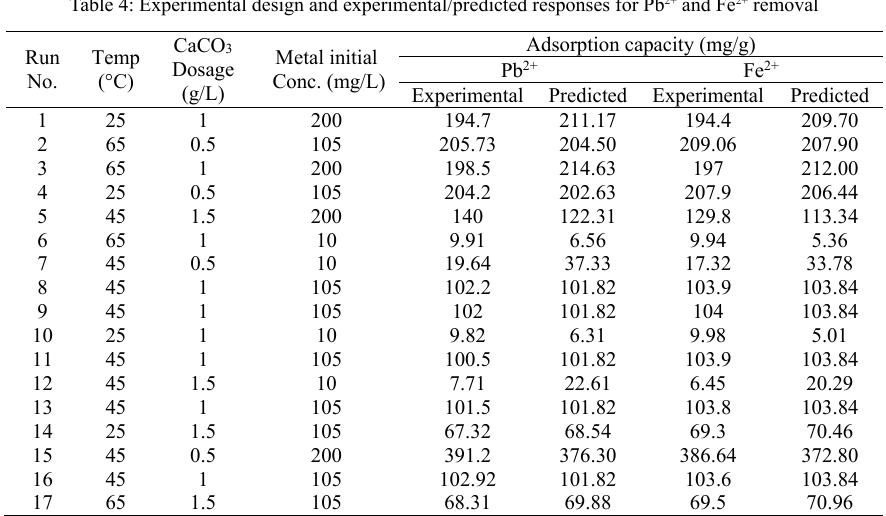
Table 5: Analysis of variance (ANOVA) results on the quadratic model for metal removal from aqueous solution